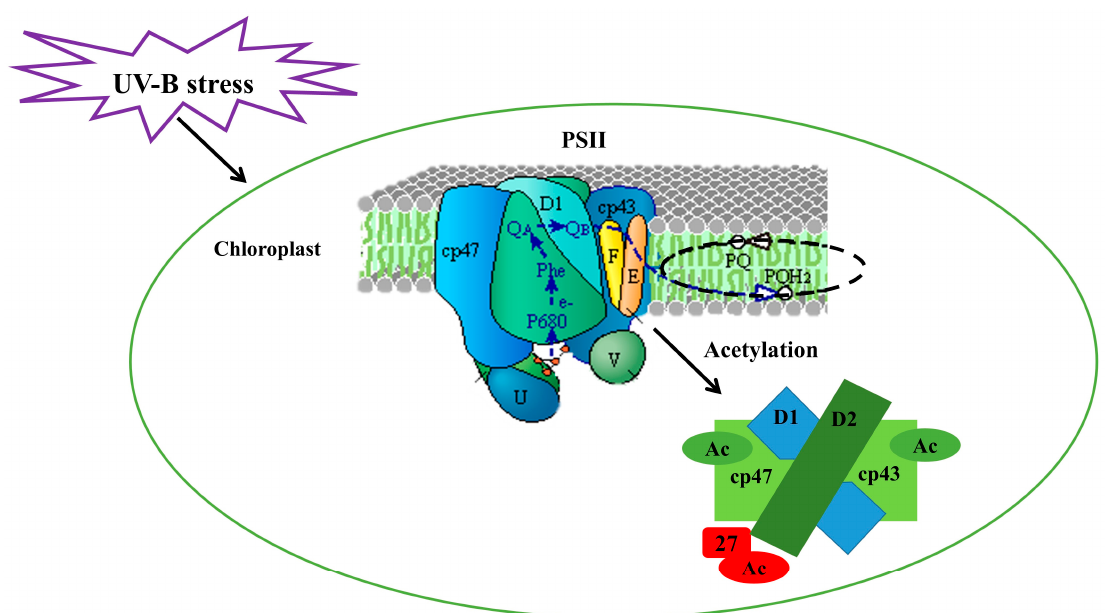
Figure 7. Pattern diagram of photosystem II protein acetylation in Rhododendron chrysanthum under UV-B stress.